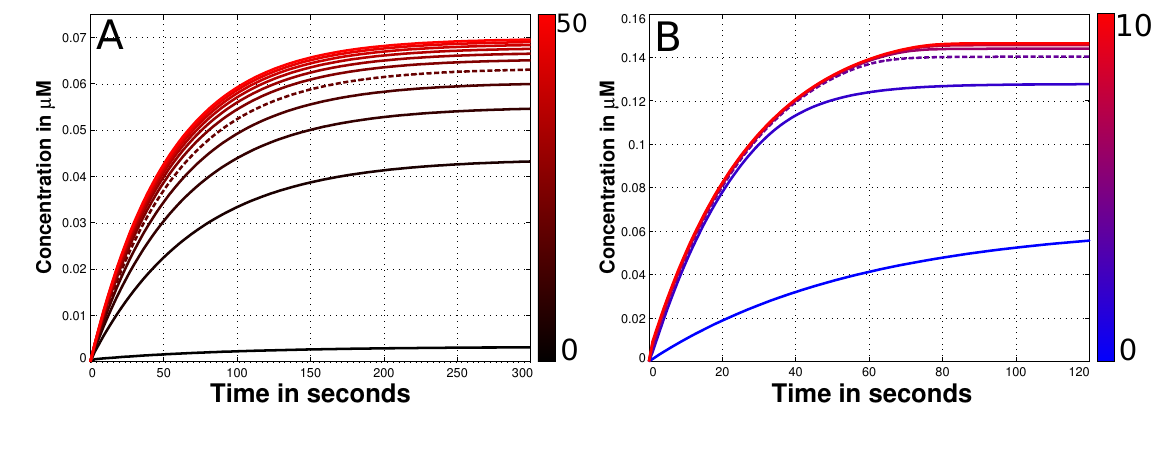
Figure 3. Diffusion and convection parameter estimation of the species O-Mad2. ( A ) Depicted is the time dependent concentration of Cdc20:C-Mad2 with different diffusion constants of O-Mad2. The variation of this rate is shown next to the plot with the color gradient. The black curve denotes a slow diffusion (0 µ m 2 s − 1 ) while red curves present fast diffusion values (up to 50 µ m 2 s − 1 ). At the end of the simulations it is a maximum of 0 . 07 µ M of the Cdc20:C-Mad2 complex formed. If the diffusion constant D is greater than i 20 µ m 2 s − 1 no significant alteration can be observed in terms of produced Cdc20:C-Mad2. Thus, we used this value for all other simulations (dashed line); ( B ) presented is again the time dependent concentration of Cdc20:C-Mad2. This time the convection rate of O-Mad2 is varied according to the color gradient. The blue curve has no convection and consequently is the same like the dashed plot in panel A. Red curves have a convection up to 10 µ ms − 1 . Exceeds the convection 4 µ m 2 s − 1 , no alteration of the formed Cdc20:C-Mad2 can be observed in steady state. As a result we used this value for the force, transporting O-Mad2 towards the spindle